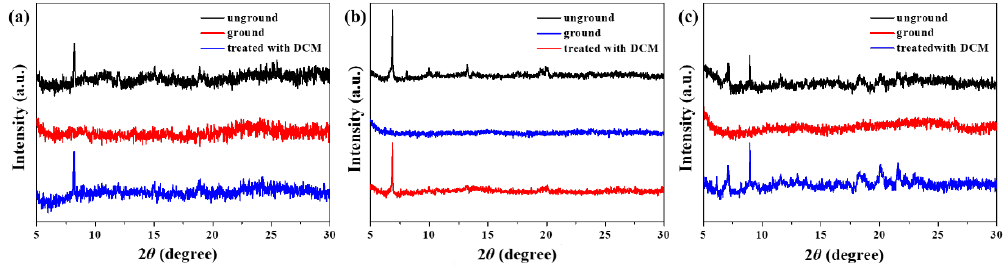
Figure 5. XRD patterns of 1 ( a ), 2 ( b ) and 3 ( c ) in various solid